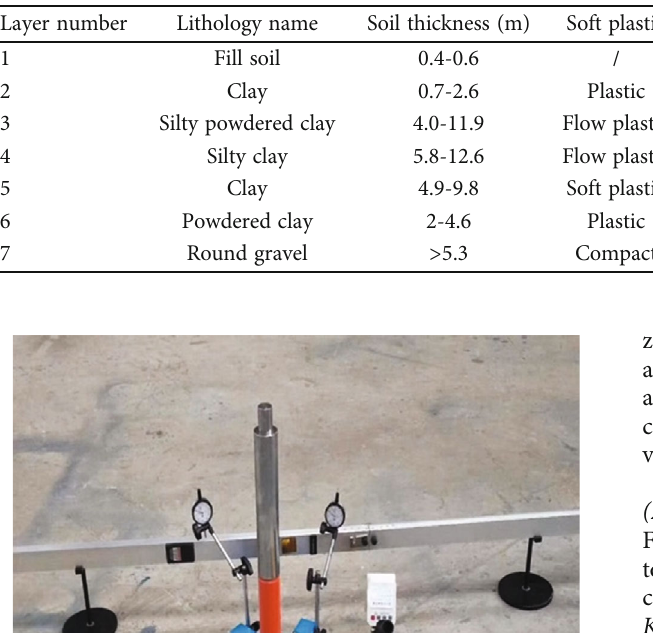
Figure 1: Geographical location of the test site. Table 1: Foundation soil distribution and physical and mechanical properties index.